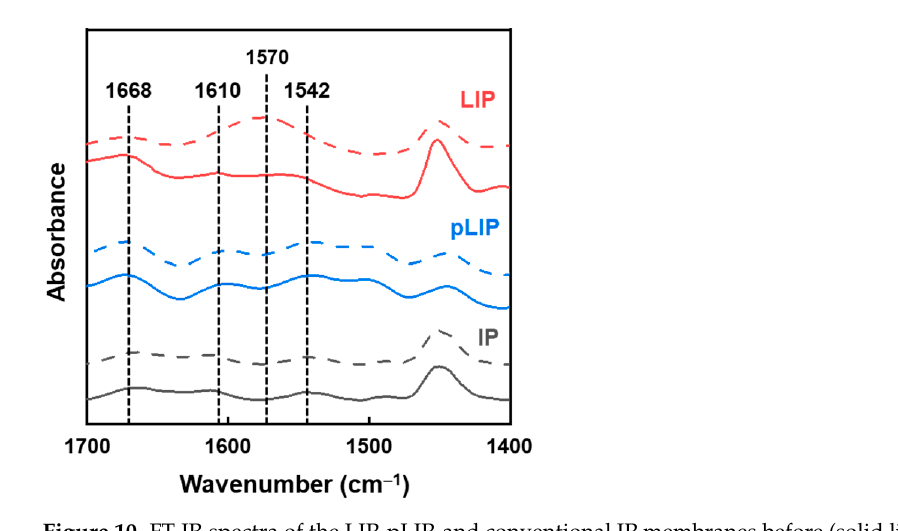
11 of 14 Figure 9. pH stability for the fabricated membranes. ( a ) Water permeance ( A ) and ( b ) NaCl rejection ( R NaCl ) of the LIP, pLIP, and conventional IP membranes as a function of the feed pH. Our claim was further confirmed by the change in the FT-IR spectra of the fabricated membranes after exposure to the acidic (pH 3) solution for 2 h, followed by the exposure to the basic solution for 2 h, as shown in Figure 10. Both the pLIP and conventional IP membranes exhibited the unchanged FT-IR spectra, even after exposure to the acidic/basic condition, which was consistent with their excellent pH stability. In contrast, the polyelec-